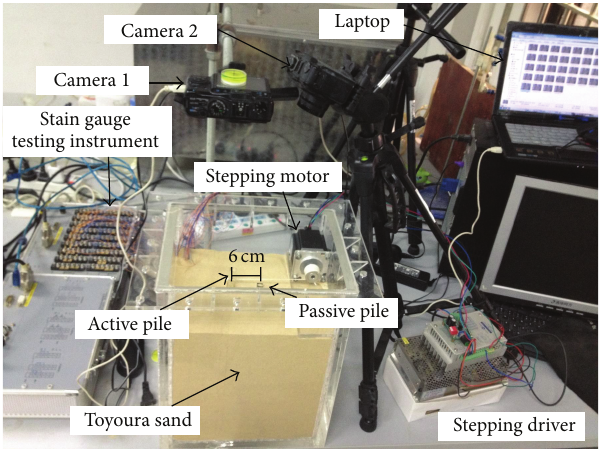
Figure 1: Experimental setup.